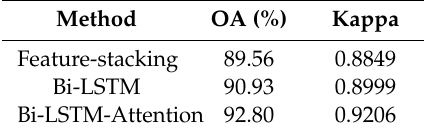
Table 6. Comparison between di ff erent spatial-temporal feature fusion methods.